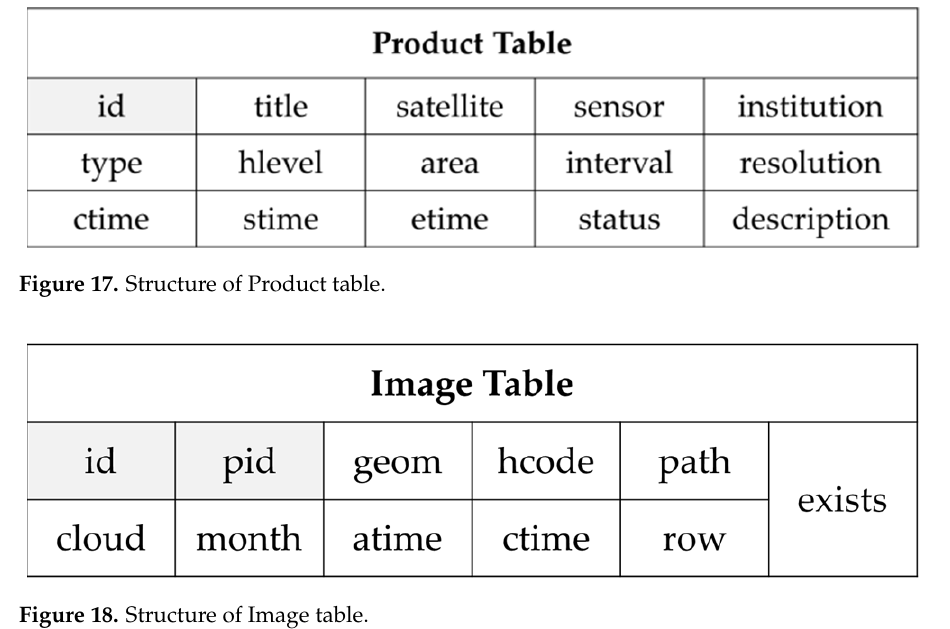
Figure 18. Structure of Image table.